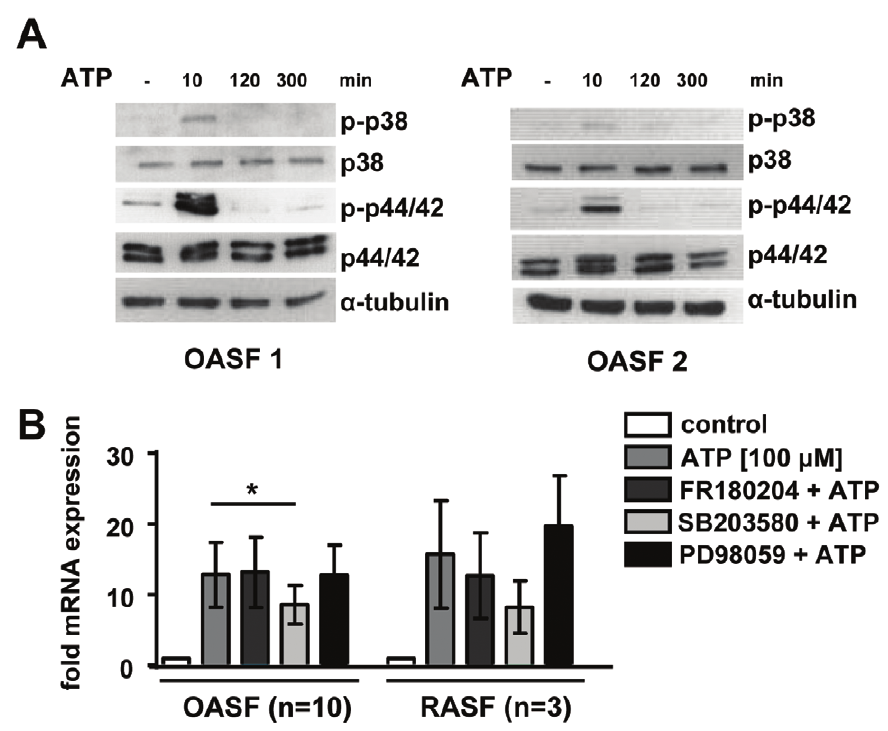
Figure 5. Activation of MAPK pathways in OASF after ATP stimulation. A . OASF were stimulated with ATP (100 m M) for 10 minutes, 2 h, 5 h and 24 h. Western blot analysis of p38 and p44/42 MAPK, as well as phosphorylated p-p38 and p-p44/42 MAPK showed kinase activation after 10 minutes ATP stimulation. B . OASF (n=10) and RASF (n=3) were treated with the kinase inhibitors FR180204, SB203580 and PD98059, respectively 15 min before ATP (100 m M) stimulation for 2 h. Data are shown as means 6 standard deviations . *, p ,